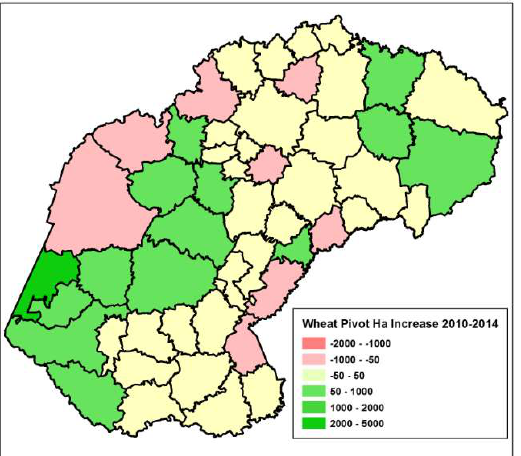
Figure 36. Wheat in winter only under pivot irrigation increase or decrease per district between 2010 and 2014